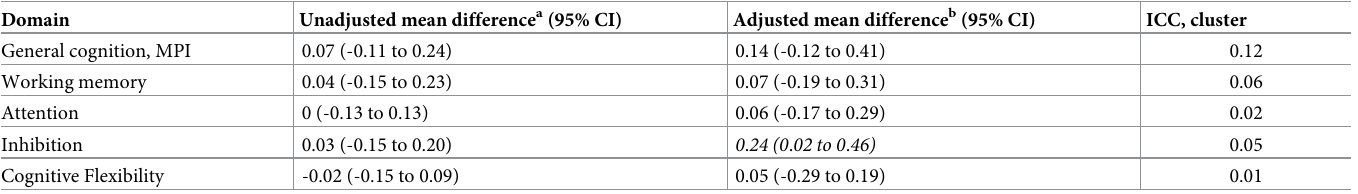
Table 6. Neuro-psychological testing results from KABAC II (General cognition, MPI and Working memory), T.O.V.A (attention and inhibition) and CCT (cogni- tive flexibility). Country-pooled results showing linear regression unadjusted and adjusted models with EBF status at 12 weeks as the dependent variable, 1-week recall. Domain